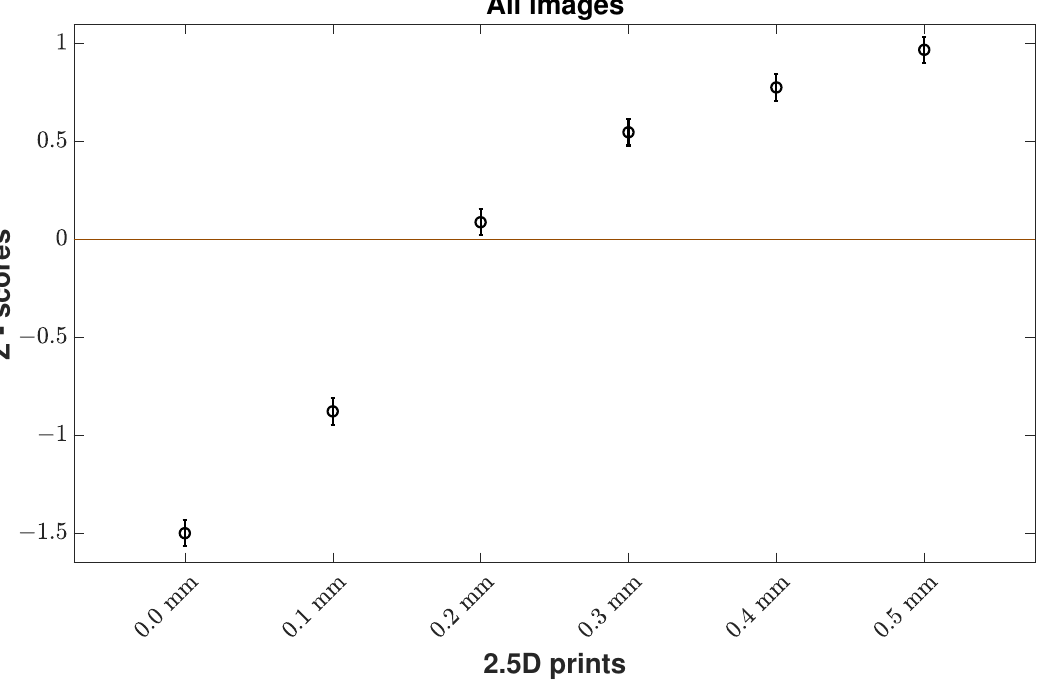
Figure 3. Z-scores of all wood images by all observers. Mean Z-score values for 2.5D prints at various elevation levels (x-axis) are given with 95% CI s. It shows that the observers found 2.5D prints with 0.5 mm as more natural looking than with no